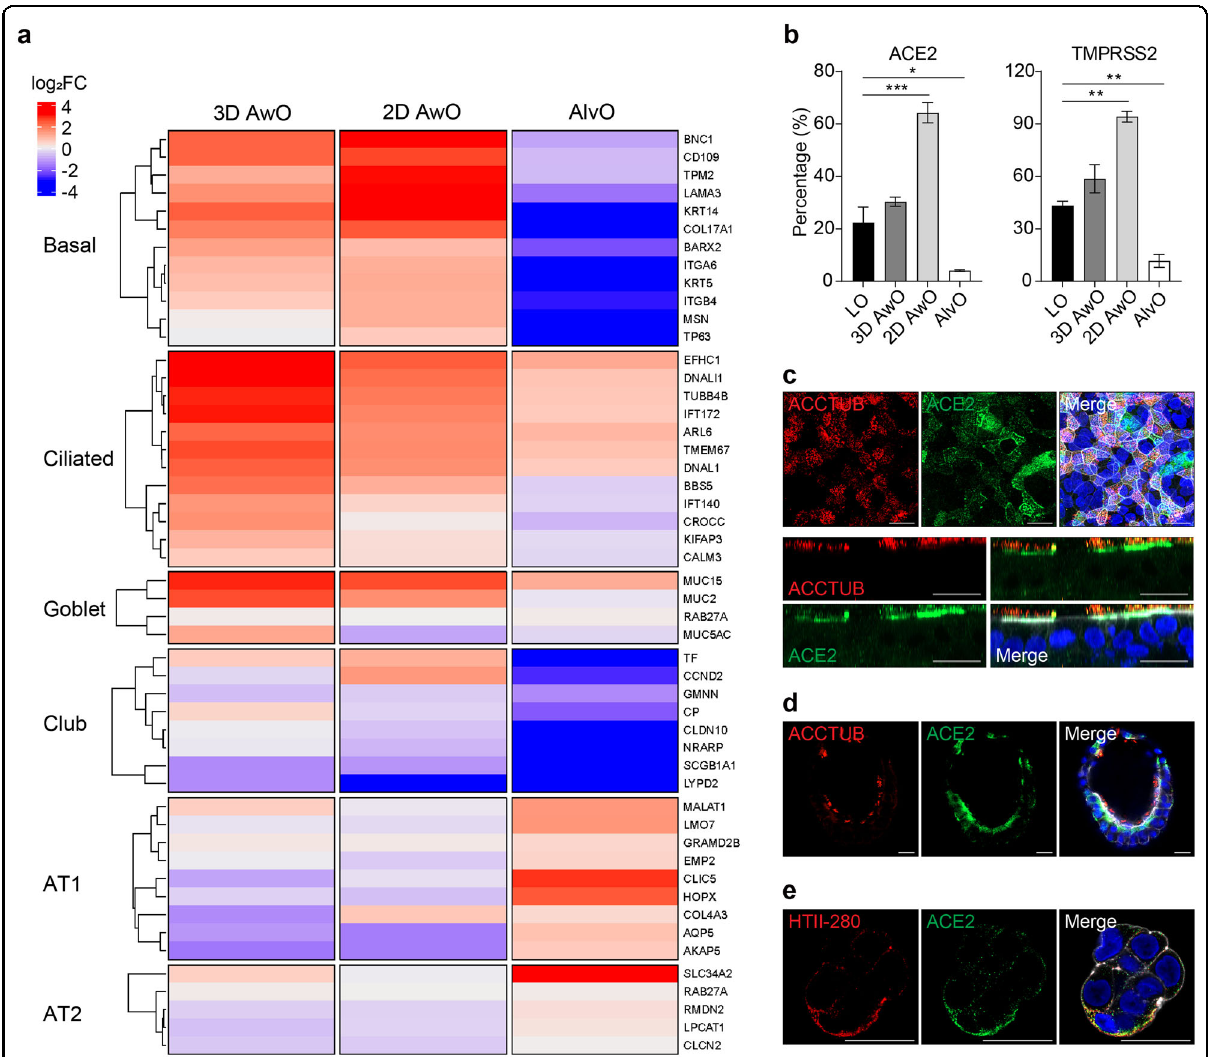
Fig. 3 Characterization of alveolar and airway organoids. a Lung organoids (LO) were applied to distal or proximal differentiation in parallel to generate alveolar organoids (AlvO) or 3D and 2D airway organoids respectively (3D AwO, 2D AwO). Heatmap depicts the top differentially expressed cell markers in the differentiated airway and alveolar organoids relative to undifferentiated lung organoids. Colored bars represent log 2 transformed fold change. b Expression of ACE2 and TMPRSS2 in LOs and the derived AlvOs, 3D AwOs, and 2D AwOs was examined by fl ow cytometry. Data represent means± SD of a representative experiment, n = 2. Ordinary one-way ANOVA with Dunnett ’ s multiple comparison test comparing differentiated organoids to the lung organoids. c – e Representative confocal images of ACE2 (green) protein. Nuclei and actin fi laments were counterstained with DAPI (blue) and Phalloidin-647 (white), respectively. Scale bar, 20µm. c 2D AwOs co-stained with α -ACCTUB (red), en face (top), and cross-section (bottom); d 3D AwOs co-stained with α -ACCTUB (red); and e an AlvO co-stained with α -HTII-280 (red). See also Supplementary Fig.